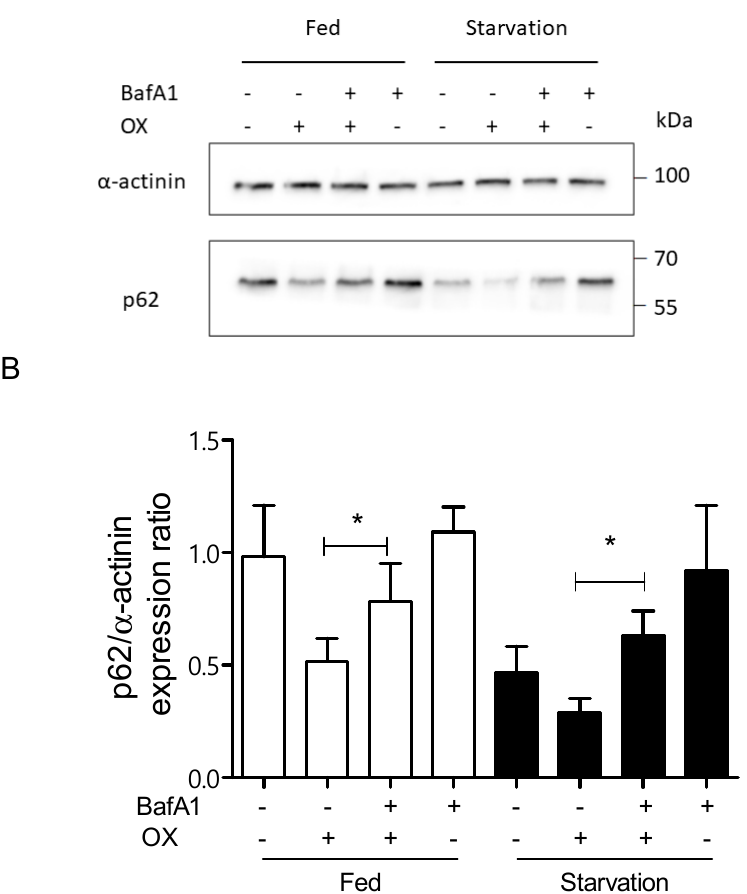
Figure 3. This figure shows the results of experiments aimed to confirm induction of autophagy flux by OX treatment in HEK293-hOCT2 cells using bafilomycin A1 (BafA1) as inhibitor of autophagy flux, and using p62 as autophagy marker. HEK293-hOCT2 cells were treated with OX (100 µM) for 6 h in the presence or absence of BafA1 (100 nM) under fed (open columns) or starvation (closed columns) conditions. The p62 expression levels were measured using Western blot analysis with α – actinin as a loading control. The panel ( A ) shows a representative Western blot analysis and panel ( B ) the quantification of 4 independent experiments. Data are expressed as mean ± SEM. * represent a statistically significant difference ( p < 0.05, paired t test) between the indicated